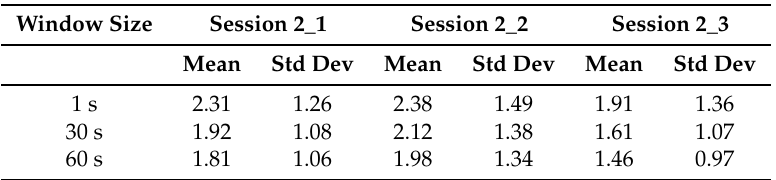
Table 5. Localization error for two-participant sessions, using BLE-Estimote data only, with both participants holding phones. All the measurements are in